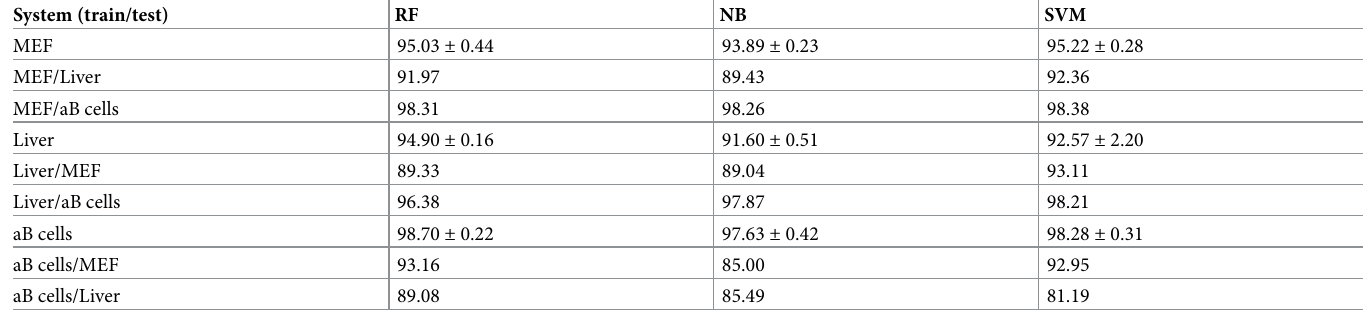
Table 4. Performance of cross system predictions using models trained with DNase-seq, RAD21 and CTCF. Errors are only shown for models trained and tested with the same system due to test data partition. System